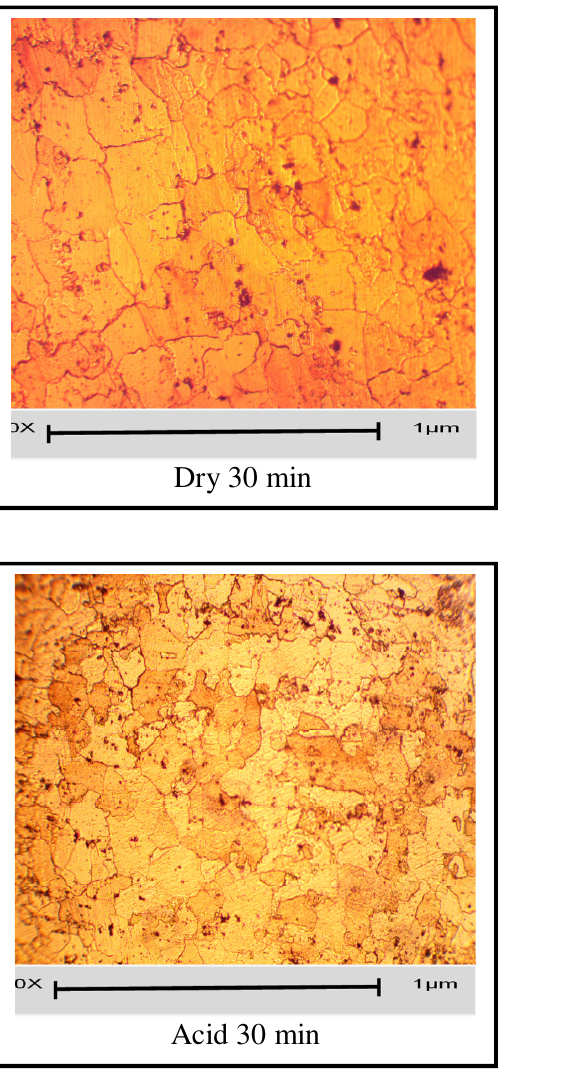
Fig. 13. Microstructure image for dry and acid mediums